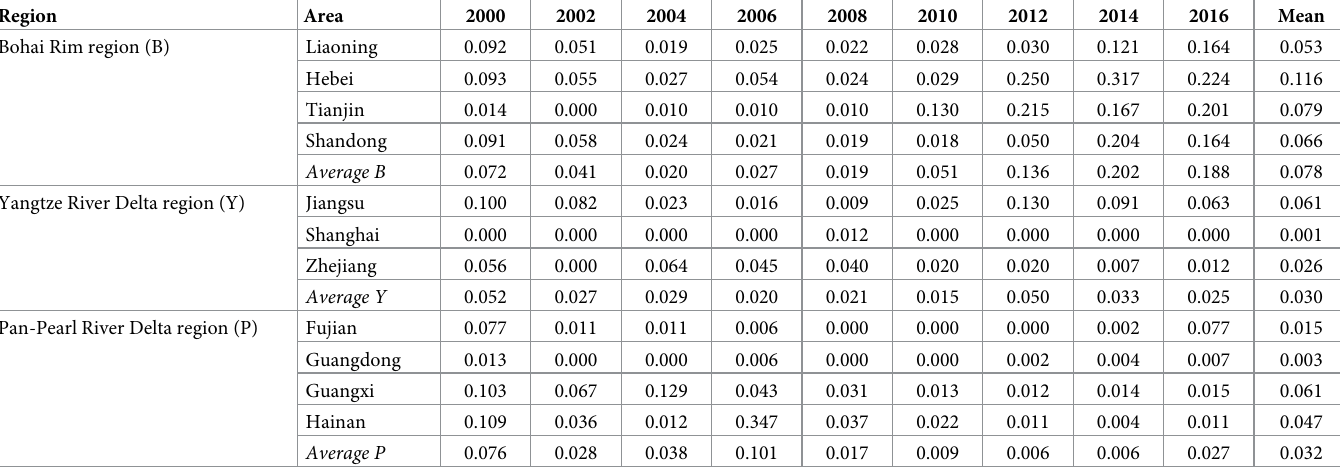
Table 3. Marine resource congestion in 11 coastal provinces and